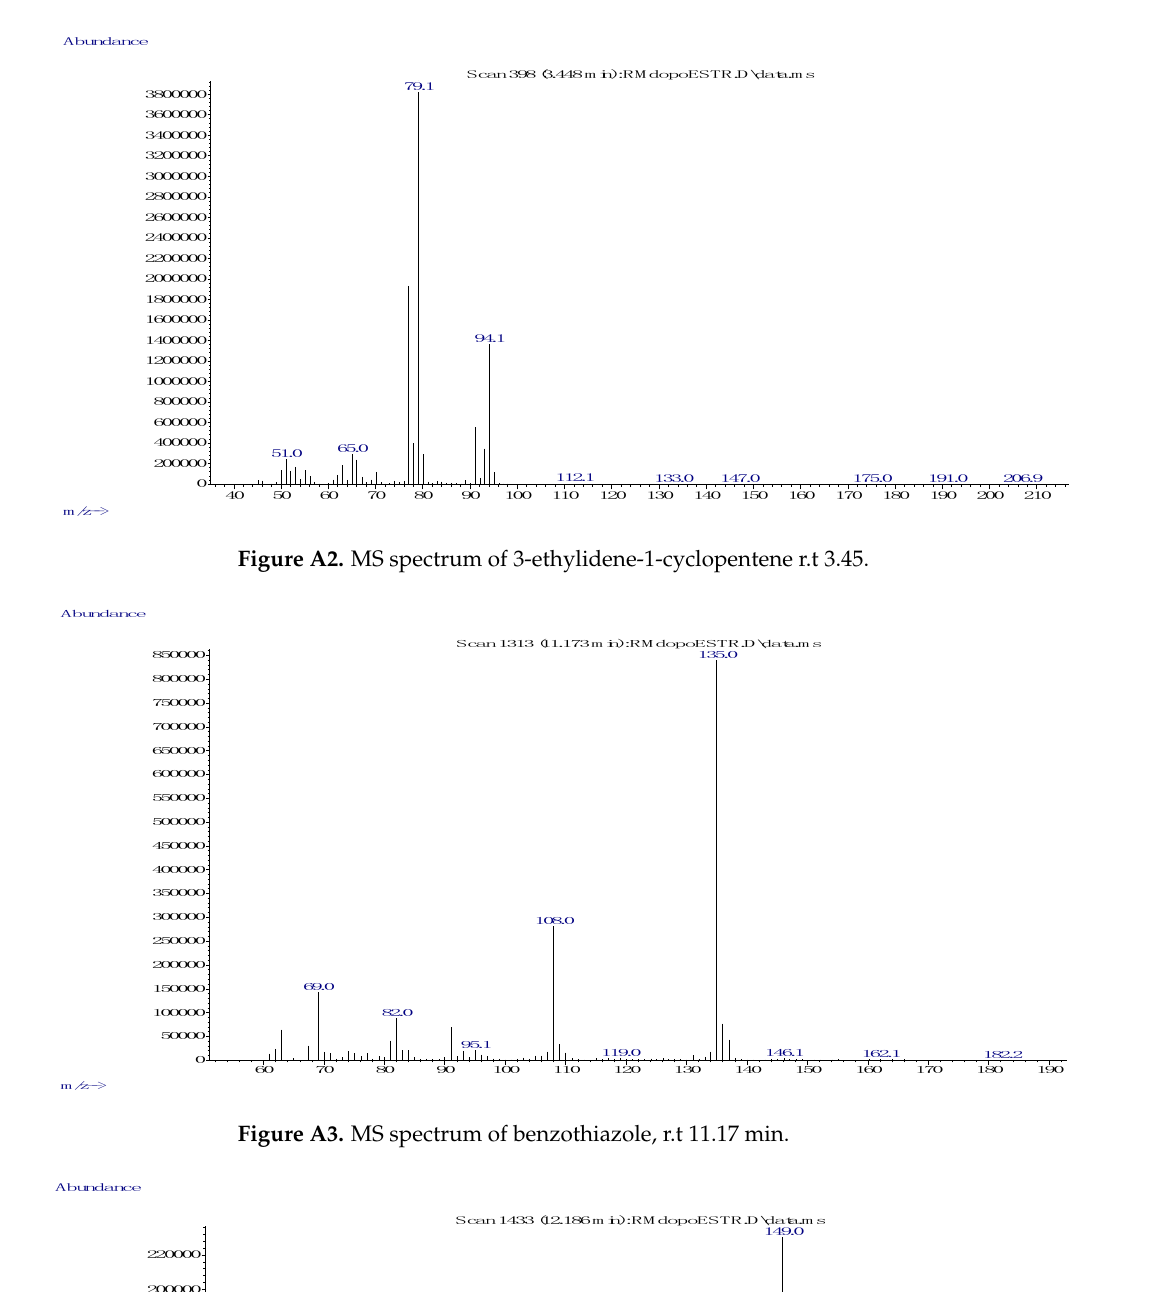
Figure A1. MS spectrum of 4-ethylidene-1-cyclopentene, r.t 3.39 min.